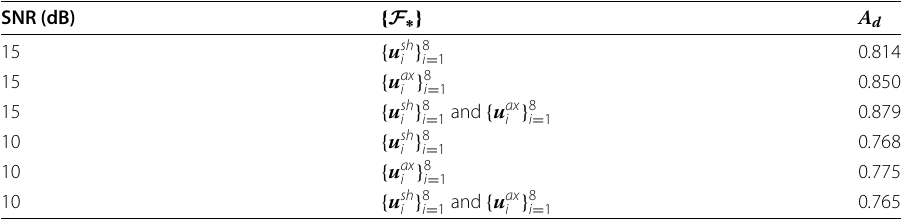
Table 3 Damage detection, case